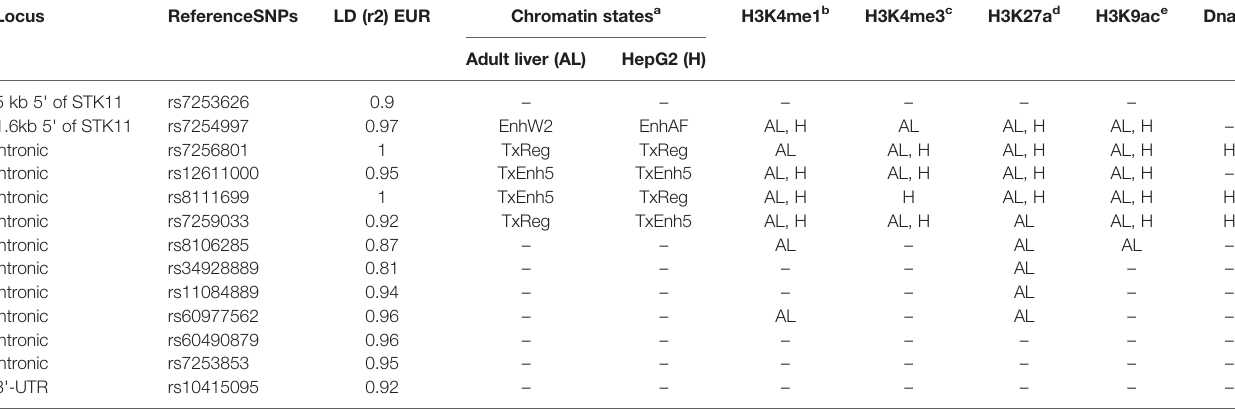
TABLE 6 | Bioinformatic characterization of SNPs in linkage disequilibrium with rs8111699 in European Population (HaploReg V4).